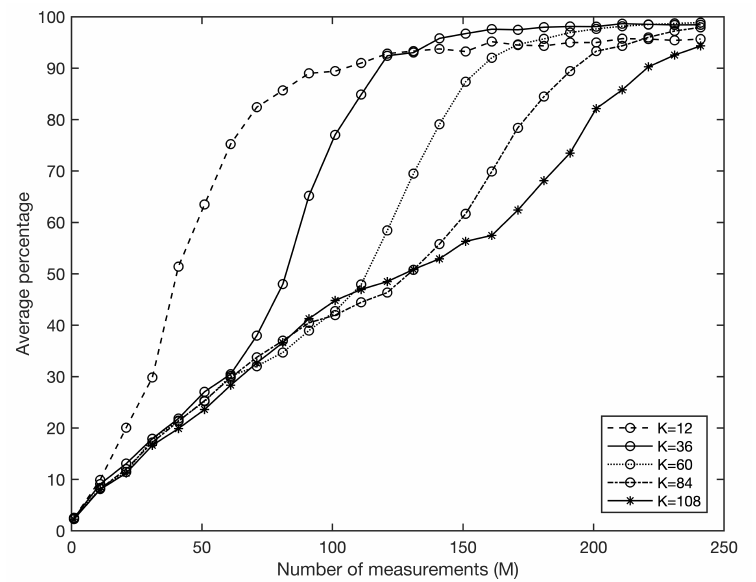
Figure 2. The average percentage of elements in support found correctly (100 input signals) as a function of the number of measurements M for different sparsity levels K in dimension N = 256 with s =